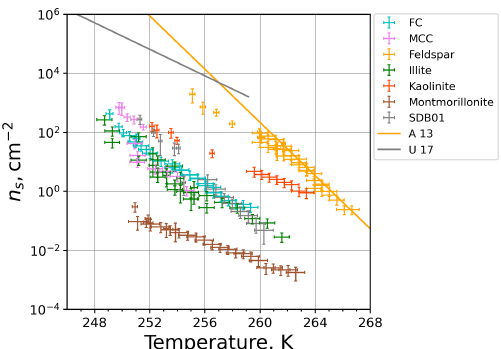
Figure 11. INAS densities of the investigated materials as a function of temperature. The data points are composites from M-WT and M- AL measurements and are corrected for the cooling rate. Orange and gray solid lines show parameterizations for feldspar (Atkinson et al., 2013) and desert dust (Ullrich et al., 2017),